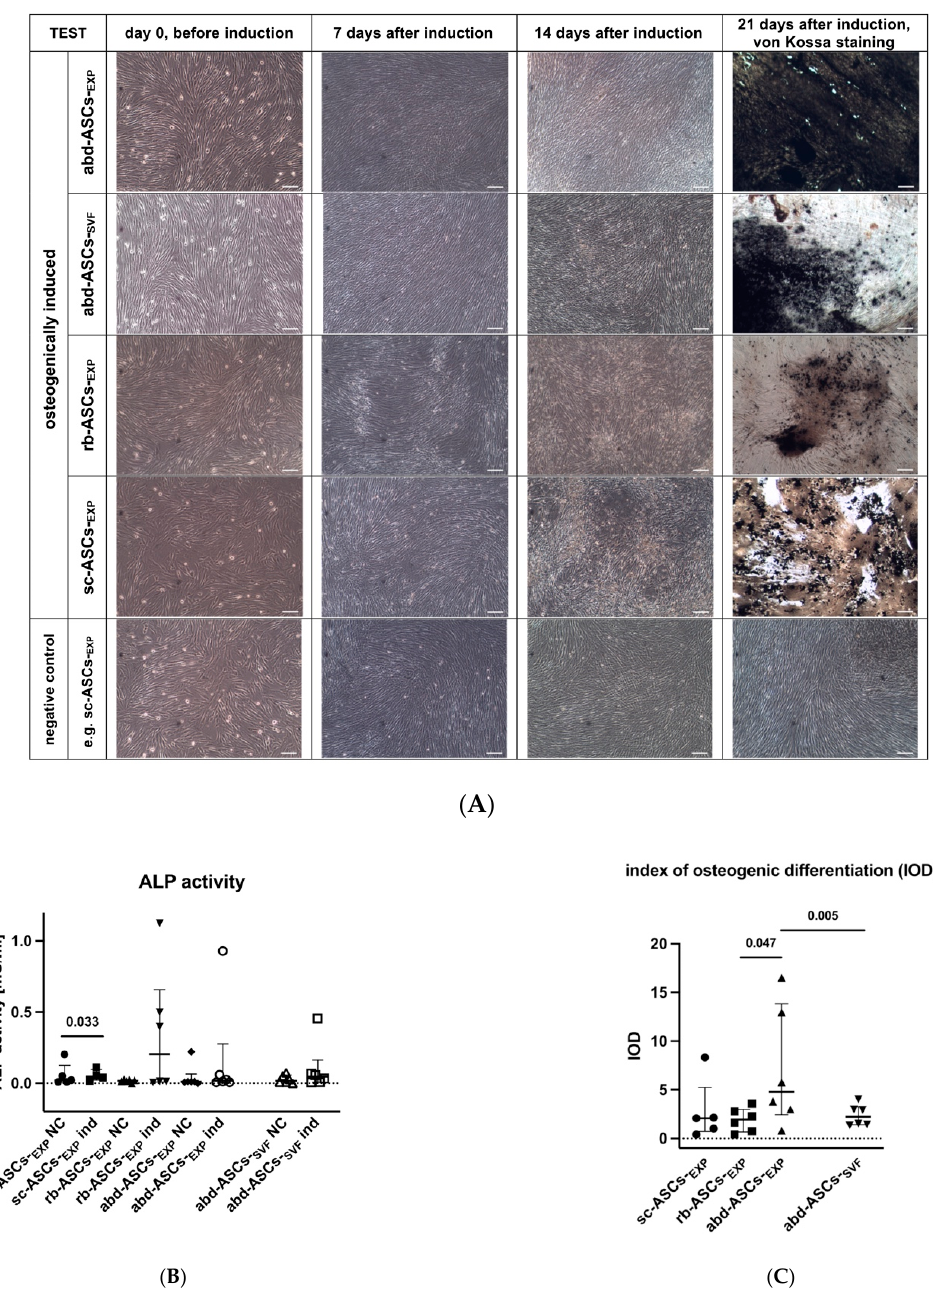
Figure 4. Osteogenic differentiation. ( A ) Transmitted light microscopic images of the osteogenic di ff erentiation of equine adipose-derived stem cells (ASCs) of one representative horse. ASCs were generated from abdominal (abd), retrobulbar (rb) and subcutaneous (sc) adipose tissue using the explant method (EXP) or using the stroma vascular fraction (SVF) after collagenase digestion. Images were taken either before (day 0) and after induction (day 7, 14 and 21). Two weeks after induction, induced cells showed bright shining, punctual, extracellular deposits compared to non-induced negative controls (NC), which increasingly turned into blackish deposits. On day 21, the calcium phosphate deposits were detected by means of Von Kossa staining. Scale bar: 100 µ m (10 × objective). ( B ) Alkaline phosphatase activity (on day 14) and ( C ) indices of osteogenic differentiation (IOD) of osteogenically induced equine ASCs (on day 21) are shown for induced (ind) and NC cells. The median value and interquartile range (error bar) are shown ( n = 6). The p -values shown are from the Mann–Whitney U test (comparisons of isolation methods and treatment effects) or from the Kruskal–Wallis test (comparisons of adipose tissue